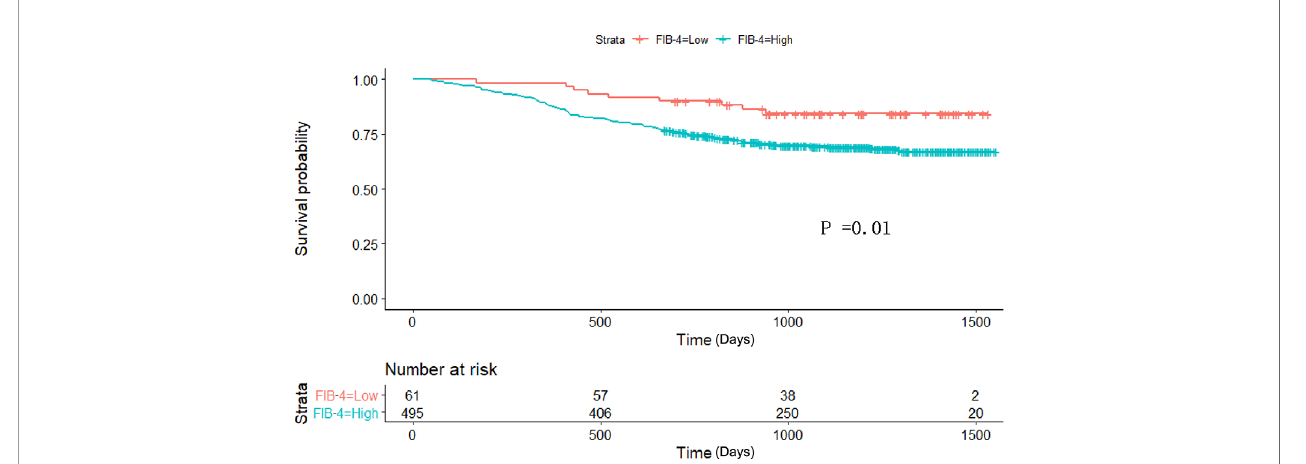
FIGURE 1 | Kaplan – Meier survival curve analyses for overall survival among the 556 patients who underwent radical gastrectomy. FIB-4 Fibrosis-4.